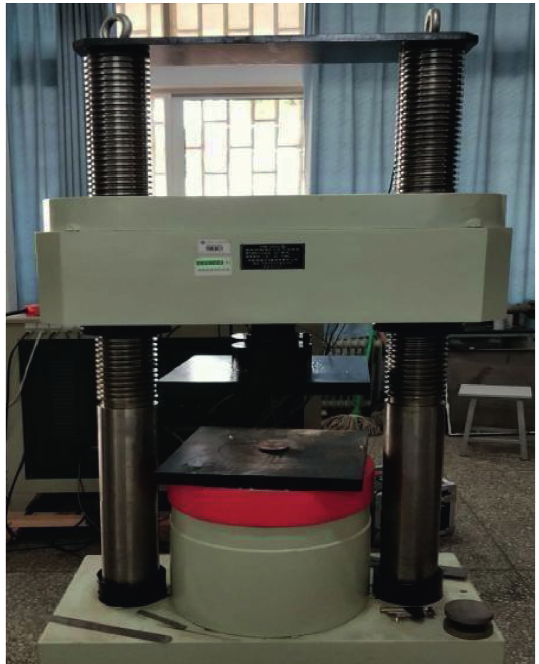
Figure 5: RFP-03 intelligent